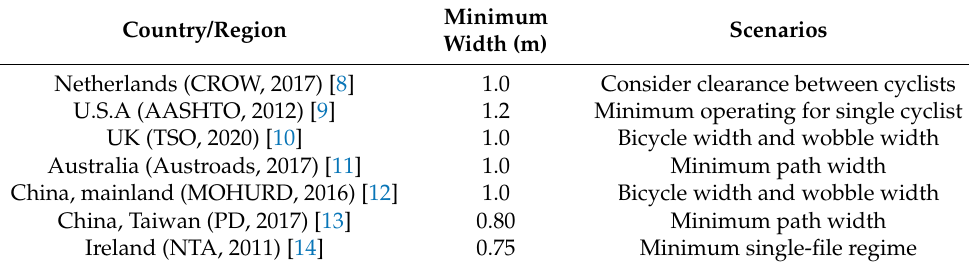
Table 4. Different scenarios and width arrangements of the test road (m). Table 3. Basic cycling widths in the guidelines of various countries or